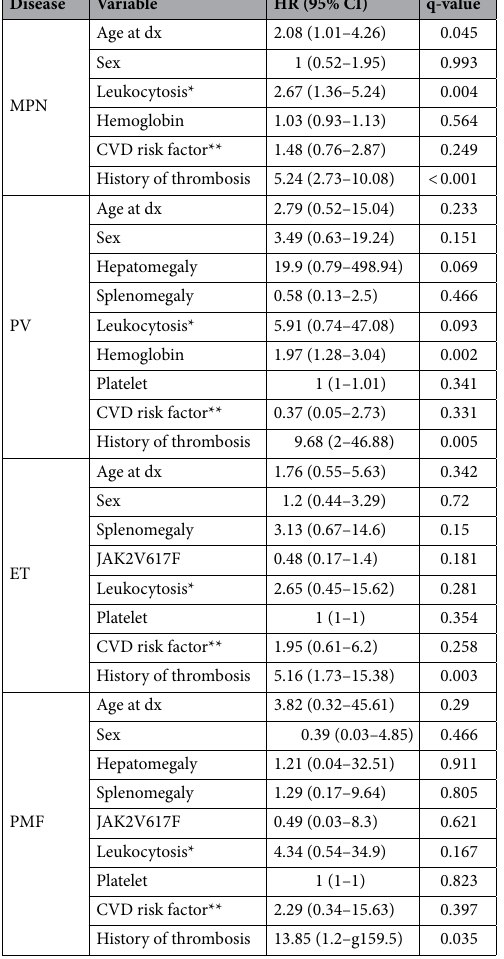
Table 2. Risk factors for thromboembolic events. * Patients who had two or more cardiovascular disease risk factors; CVD risks were defined as obesity (BMI > 25), smoking, hypertension, diabetes